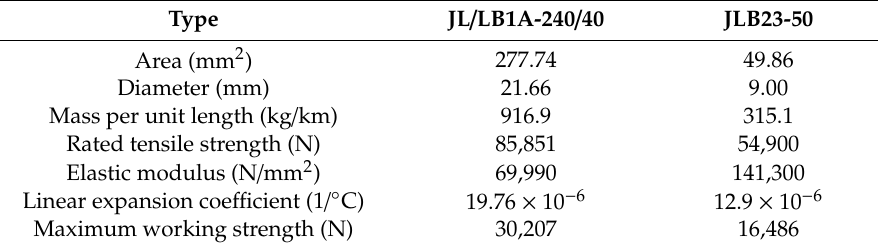
Figure 12. Safety factor, R , of windage yaw flashover. ( a ) Conductors/ground wires. ( b ) Insulator string.